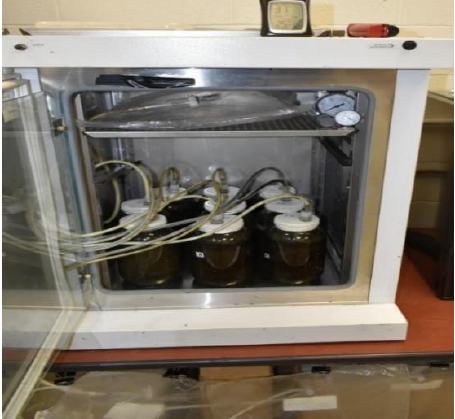
Figure 1. The scheme of the reactors, tubes transferring biogas and the incubator.